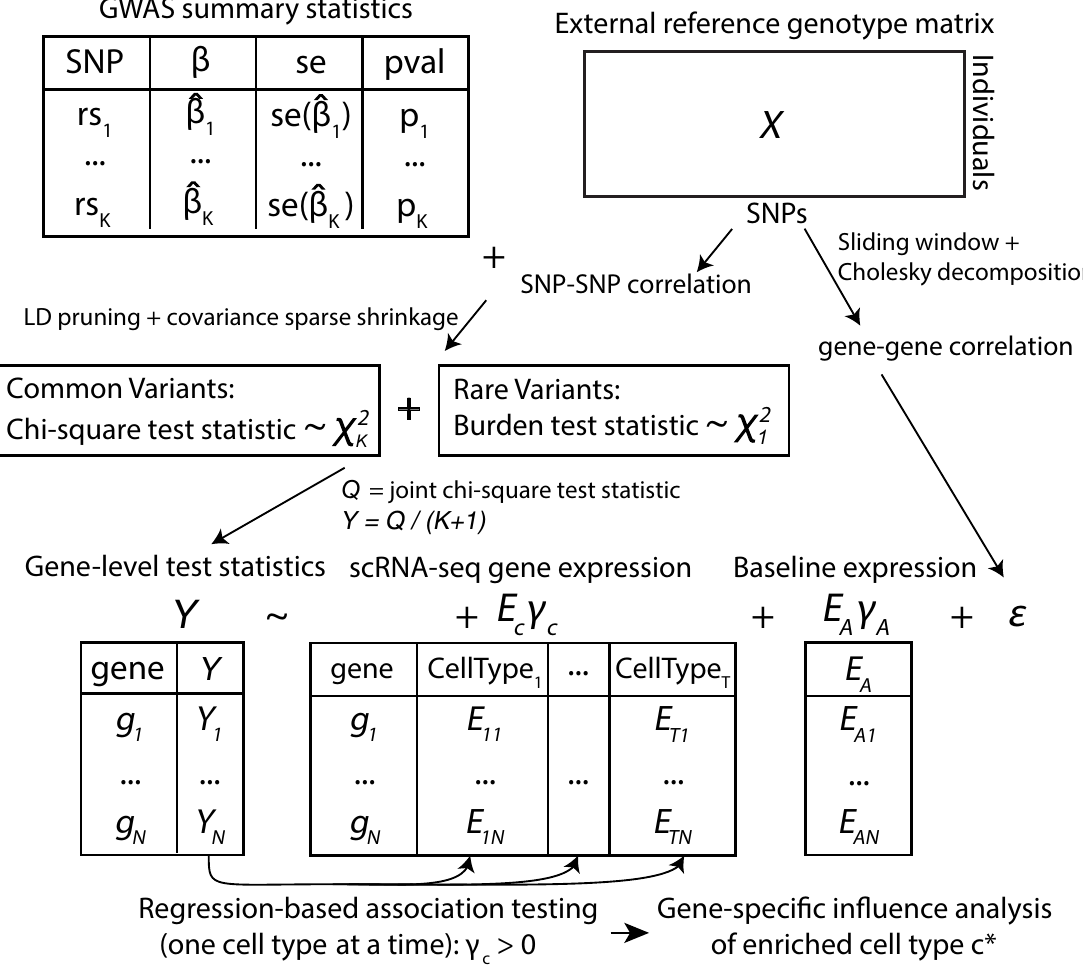
Fig 1. Overview of EPIC framework. EPIC starts from GWAS summary statistics and an external reference panel to account for LD structure. To ensure that the correlation matrix is well-conditioned, EPIC adopts the POET estimators to obtain a sparse shrinkage correlation matrix. EPIC performs LD pruning, computes the gene-level chi-square statistics for common variants, and calculates burden test statistics for rare variants. EPIC then integrates gene-level association statistics with transcriptomic profiles and prioritizes trait-relevant cell types using a regression-based framework while accounting for the gene-gene correlation